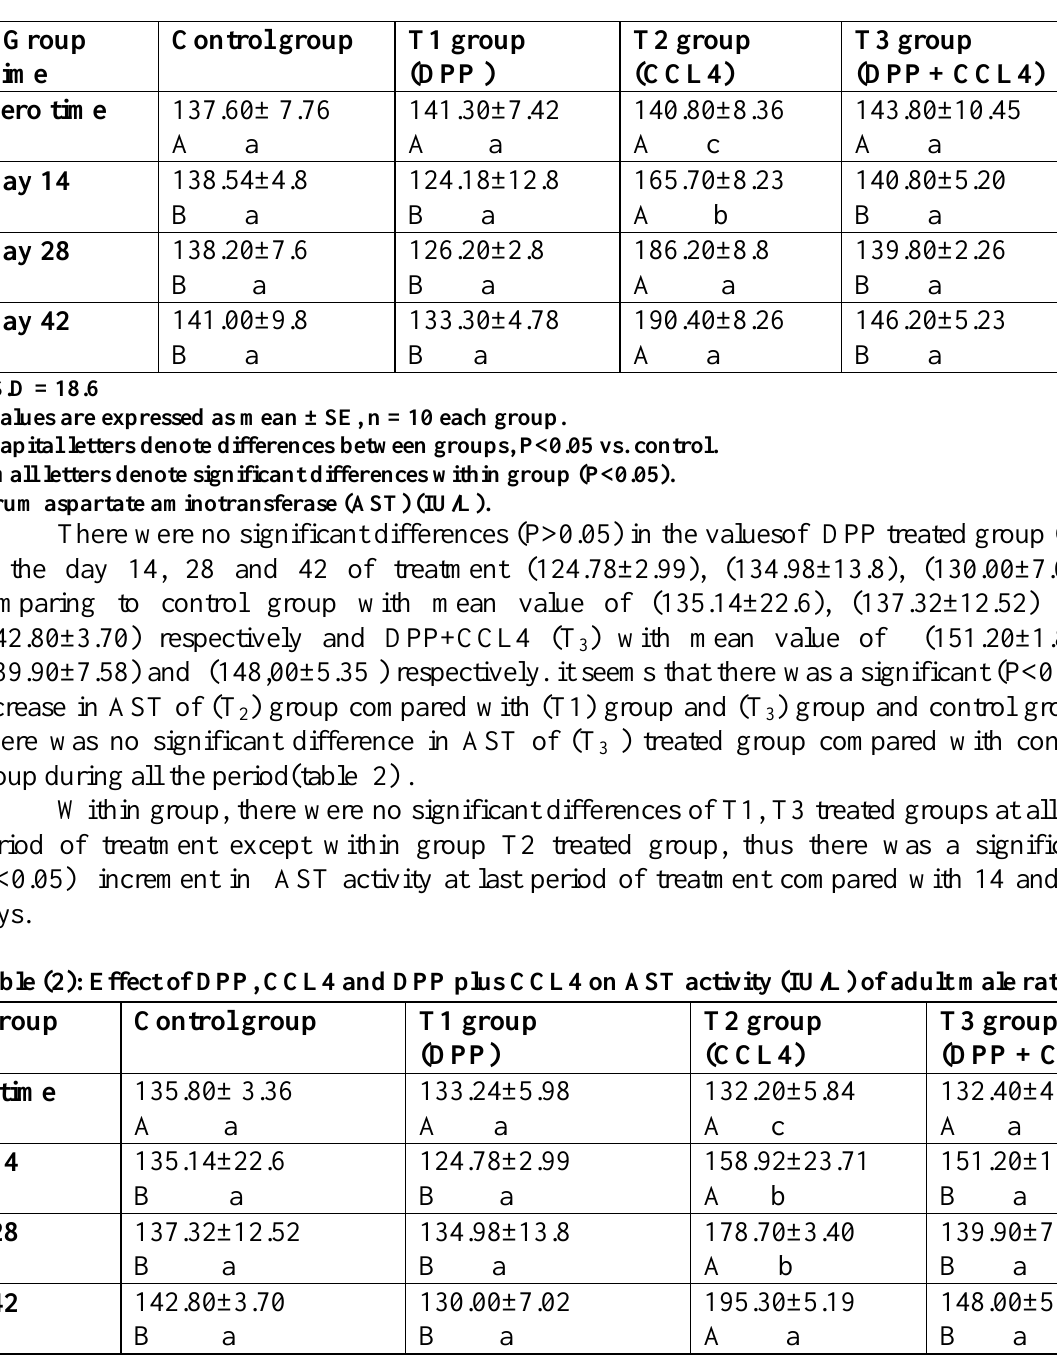
Table (1) Effect of DPP, CCL4 and DPP plus CCL4 on ALP activity (IU/L) of adult male rats.